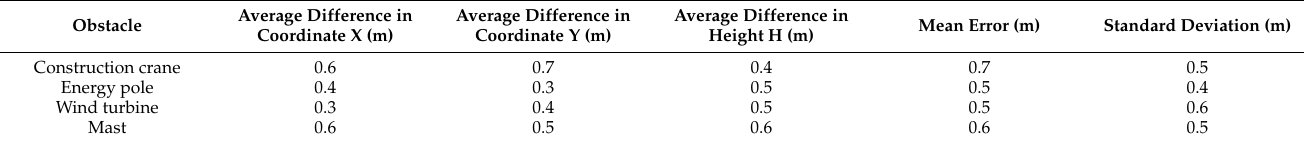
Table 4. Statistical values that characterise the matching accuracy of the point